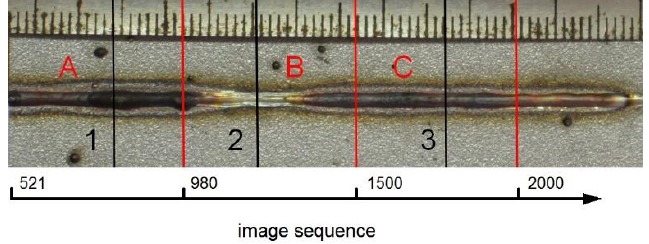
Figure 4. Top view of the welded seam. Three regions A, B, C were divided, and three different cross sections marked with 1, 2, and 3 were selected.